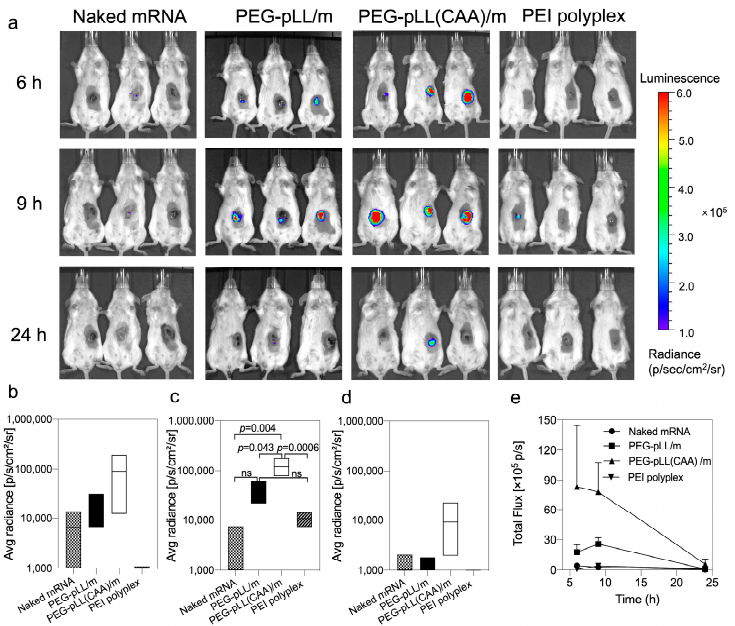
Figure 4. In vivo transfection of micelles. ( a ) Representative bioluminescence images following in vivo delivery of fluc mRNA in CT26 tumor-bearing mice. Mice were intratumorally injected with naked fluc mRNA, fluc mRNA-loaded PEG-pLL/m, fluc mRNA-loaded PEG-pLL(CAA)/m and PEI fluc mRNA polyplexes (5 µg mRNA per mouse, n = 3), and imaged at 6, 9 and 24 h post-injection. Quantification of luminescence signals from IVIS images at ( b ) 6 h, ( c ) 9 h and ( d ) 24 h post-injection. Data were expressed as the mean ± s.d. ( n = 3). Statistical significance was calculated by the one-way ANOVA test. ns means not significant. ( e ) Quantification analysis of luminescent signals at indi- cated time points.